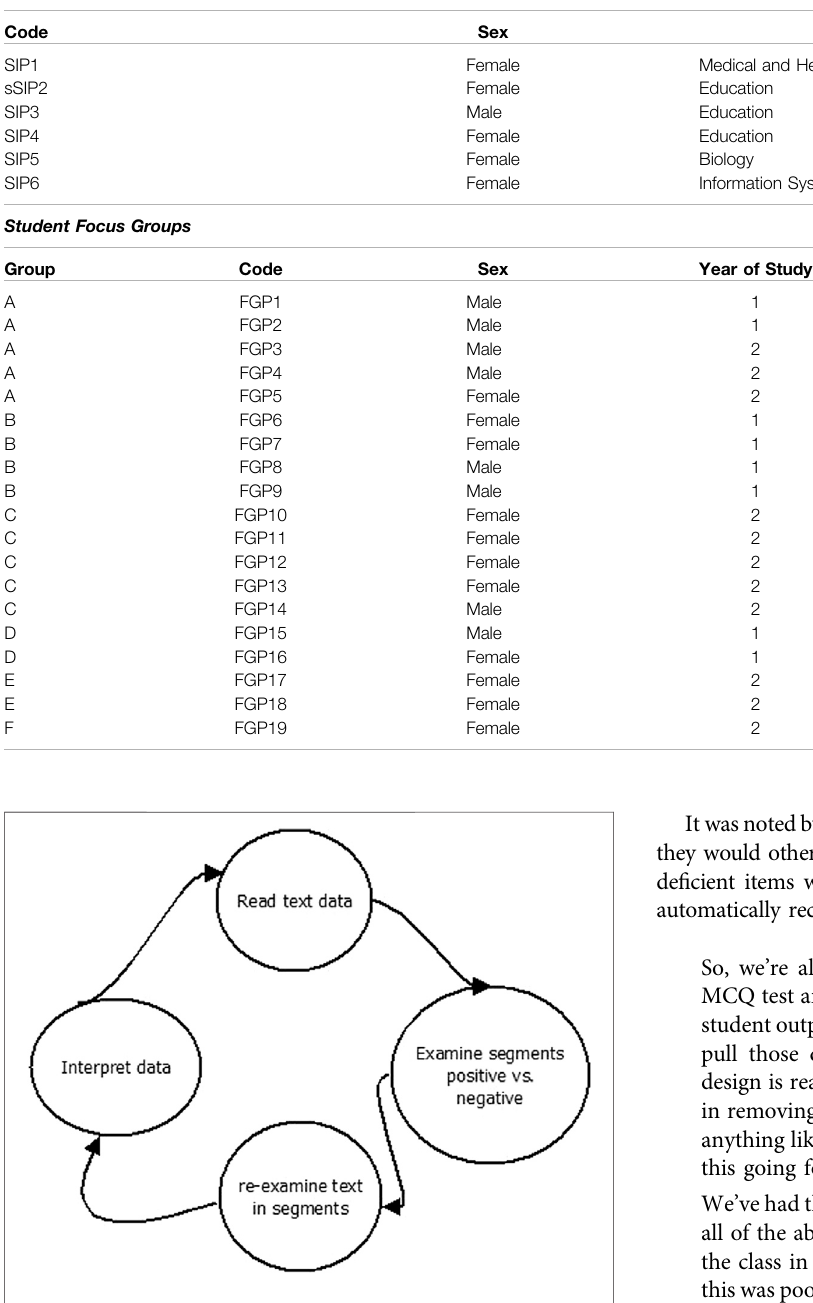
FIGURE 6 | Qualitative Data-Analysis Plan and the study ’ s iterative analytic